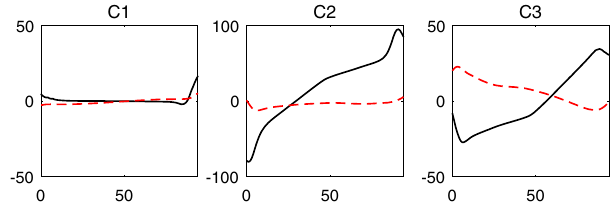
FIG. 10. Plot of the numerically measured gradient parameters Q 1 (dashed line) and Q 2 (solid line) versus the path length (in mm) along the inflectors. Note that the C2 graph has a different vertical scale.